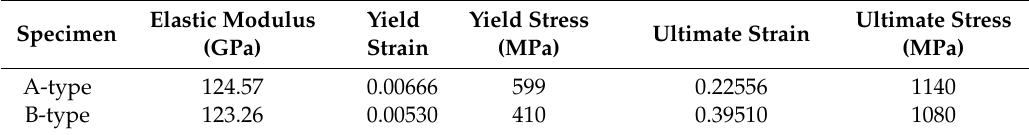
Figure 1. Stress–strain curves according to type of Fe-SMA [12]. Table 2. Mechanical properties of the Fe-SMA [12].